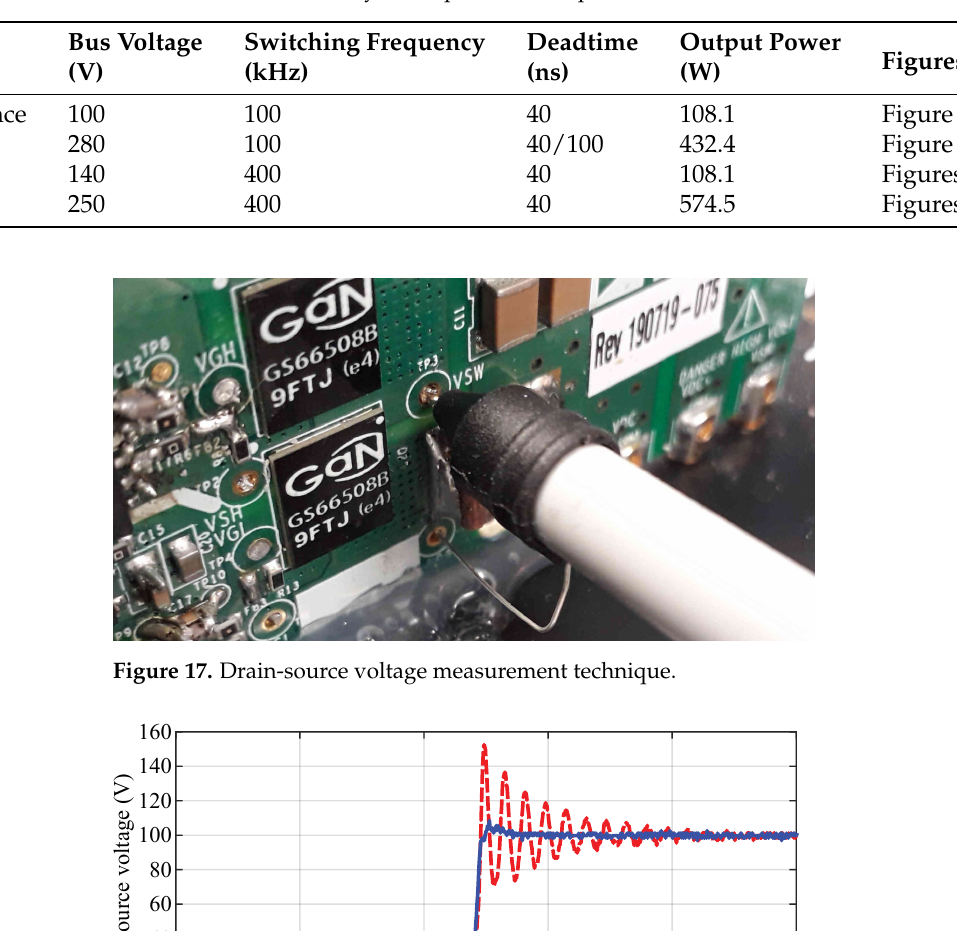
Table 4. Summary of the performed experiments.